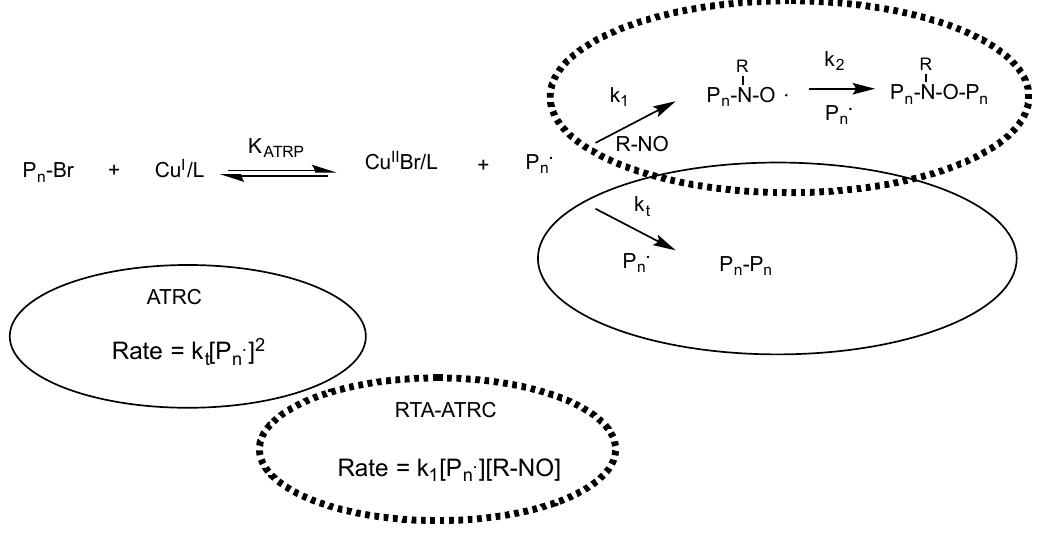
Scheme 2. Comparison of the mechanism and rate equation for ATRC (solid circle) and RTA-ATRC. (dashed circle).